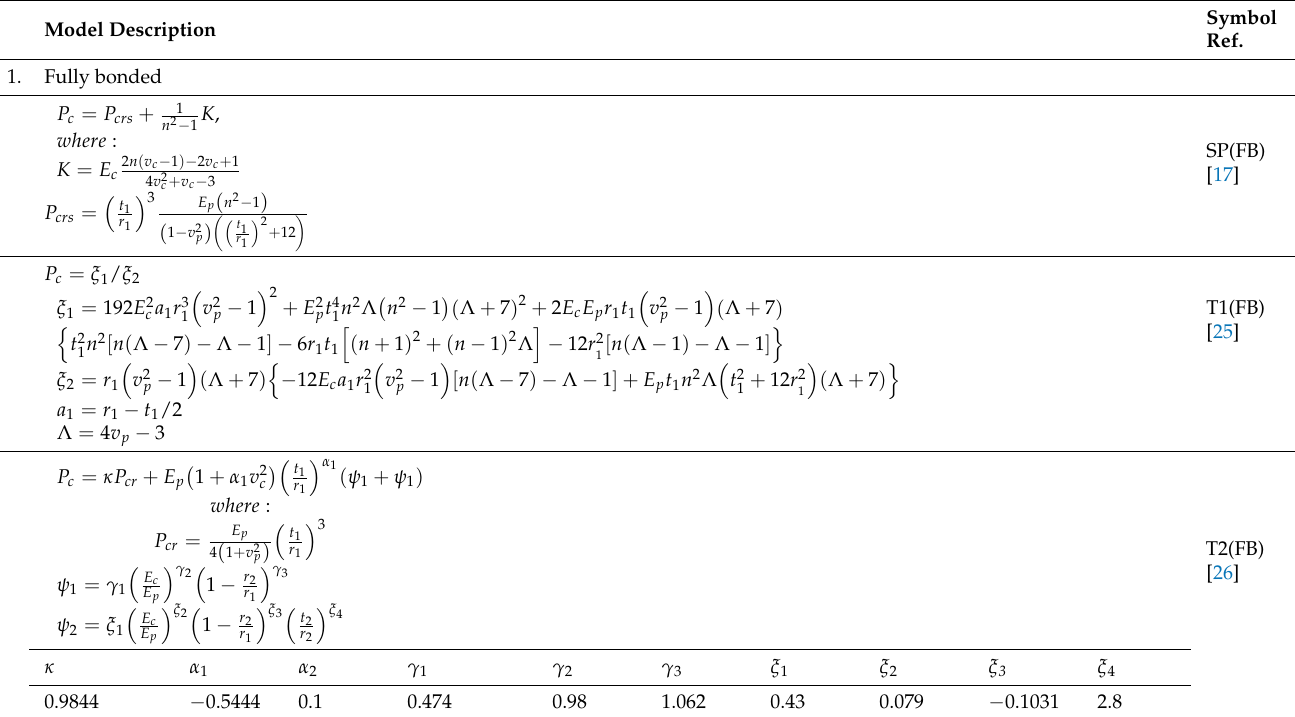
Table A1. Collapse strength models for sandwich